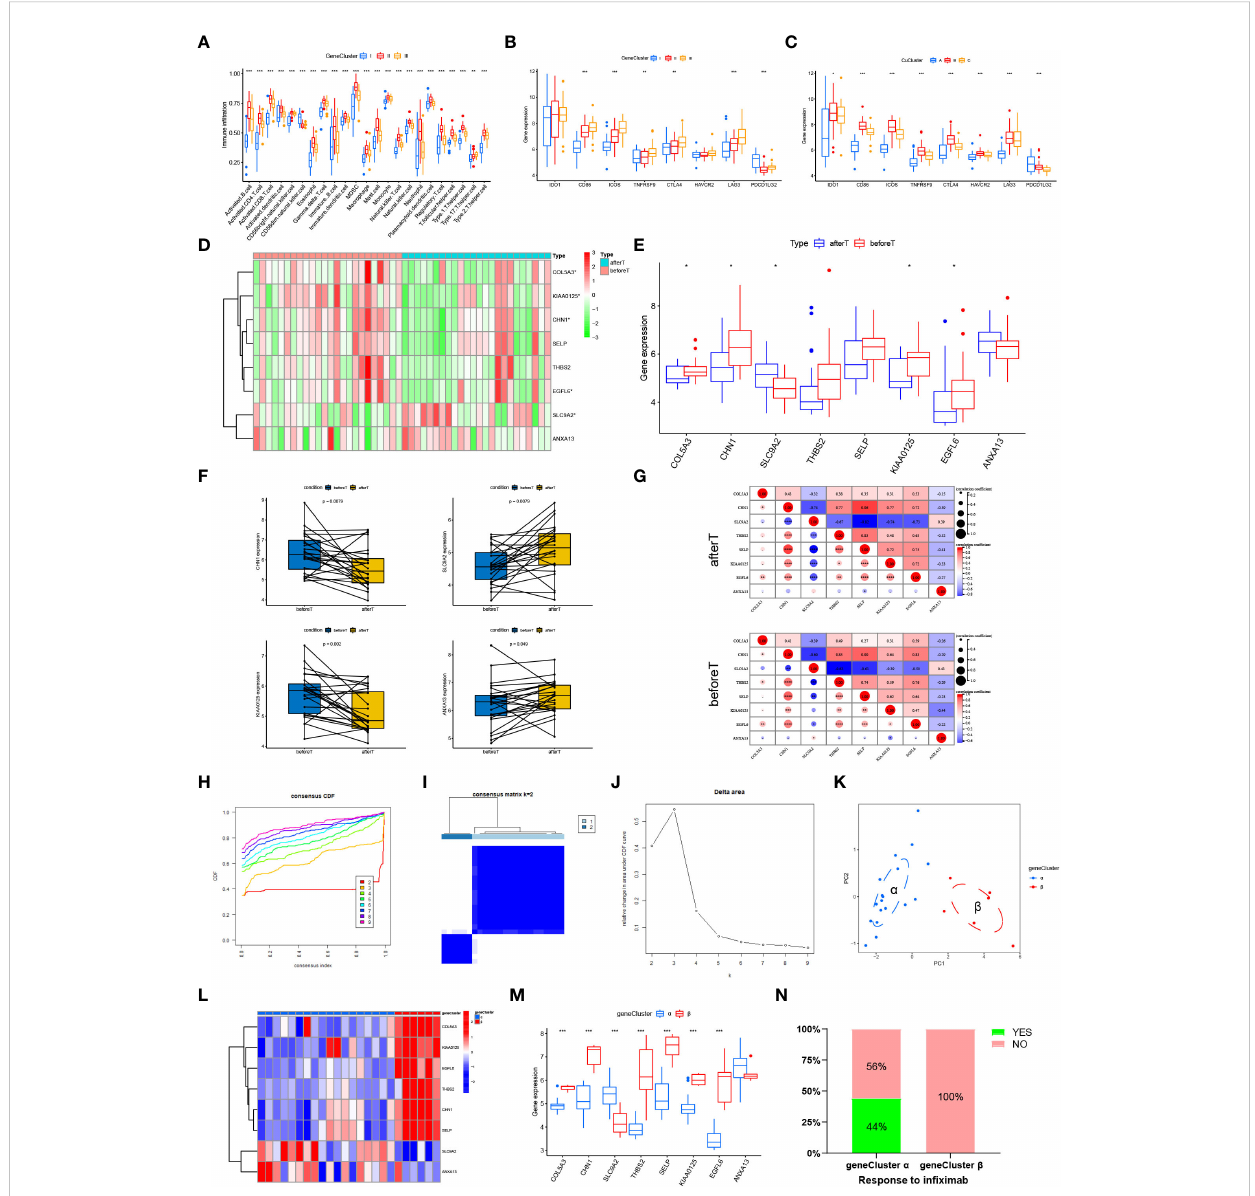
FIGURE 5 Cuproptosis phenotype-associated hub genes affect immune in fi ltration and treatment response. (A) Levels of immune cell in fi ltration in different GeneClusters. (B, C) Differential expression of eight important immune checkpoints in different CuClusters (B) and GeneClusters (C) . (D, E) The expression of eight hub genes in responders before and after the fi rst in fl iximab treatment. (F) The expression of a single gene in responders before and after the fi rst in fl iximab treatment. (G) Correlations between eight hub genes were analyzed in responders before and after the fi rst in fl iximab treatment. (H – J) Clustering of samples based on cuproptosis phenotype-associated hub gene expression using unsupervised consistency clustering to identify three subgroups. (K) Visualization of clustering results using the PCA method. (L, M) Expression of cuproptosis phenotype-related hub genes in GeneClusters. (N) Treatment response of in fl iximab in different GeneClusters. N, normal, normal tissues; U, UC, UC patients; CuClusterA, cuproptosis-ClusterA; CuClusterB, cuproptosis-ClusterB; CuClusterC, cuproptosis-ClusterC. Before T represents responders before the fi rst in fl iximab treatment. After T represents responders after the fi rst in fl iximab treatment. The asterisk represents the statistical p -value (* p < 0.05; ** p < 0.01; *** p <